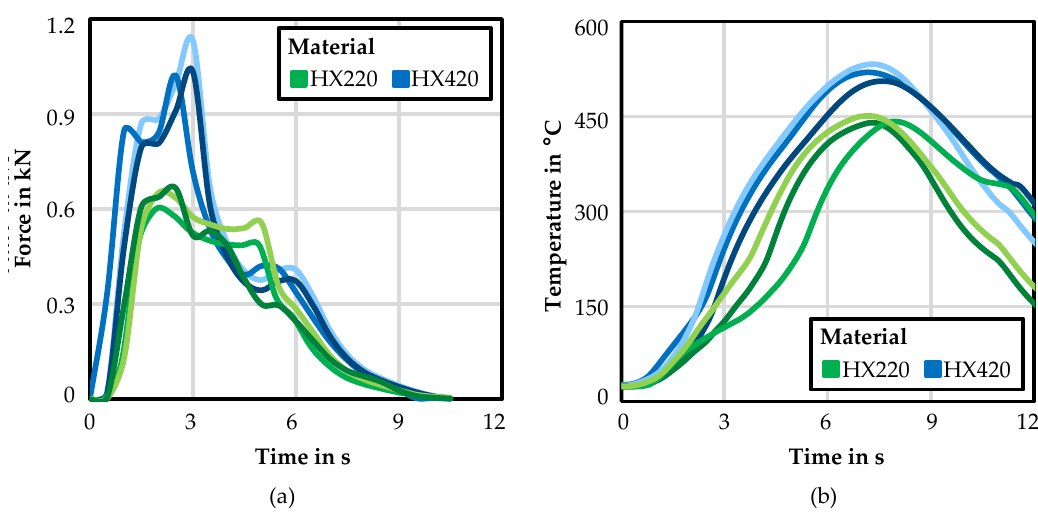
Figure 9. Experimental measured force–time curves ( a ) and temperature–time curves ( b ) for friction drilling HX220 at a 1.2 mm sheet thickness, as well as HX420 at 1.5 mm, for three repetitions each.